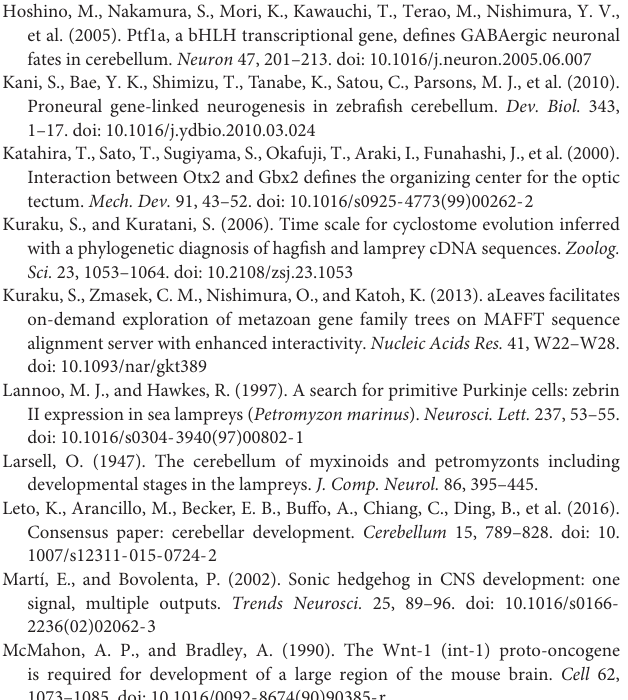
Supplementary Figure 3 | Phylogenetic trees of Wnt1 (A) and Ptf1a (B) genes. The trees were inferred with the maximum-likelihood method using 355 and 153 aligned amino acid sites, respectively. The support values at nodes indicate bootstrap values and posterior probabilities based on the maximum-likelihood method and Bayesian inference in order, respectively. See the section “Materials and Methods” for details. Supplementary Table 1 | Primers used for gene cloning and probe